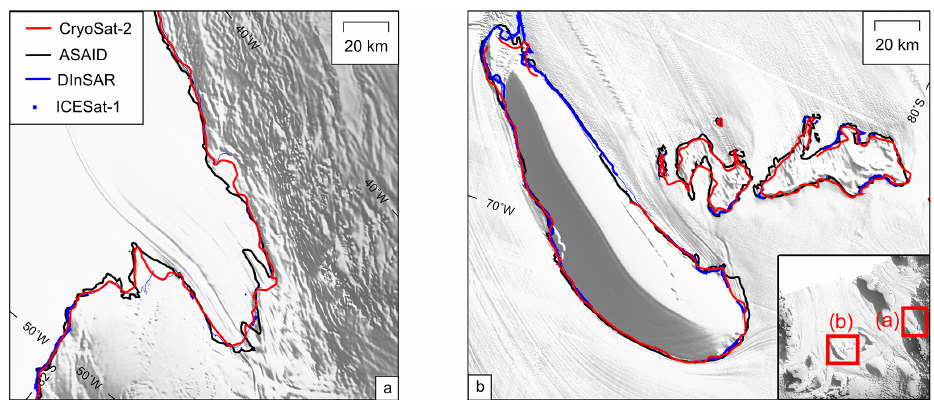
Figure 5. Grounding line mapped using DInSAR from both the MEaSUREs and the ESA CCI grounding line and ICESat-1 (blue), break in slope from the ASAID project grounding line (Bindschadler et al., 2011) (black) and CryoSat-2 (red) methods for (a) Support Force Glacier and (b) Doake Ice Rumples. The background image is overlain on the REMA digital elevation model (DEM) (Howat et al.,